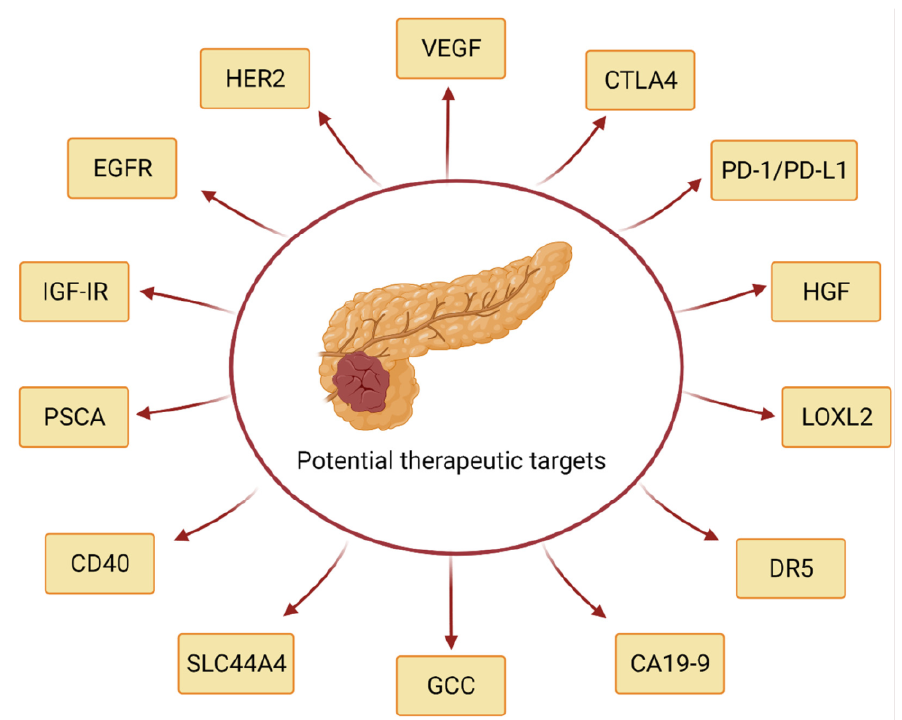
Figure 2. Antigens targeted by antibodies in patients with pancreatic cancer. Created with BioRender. com (accessed on 17 March